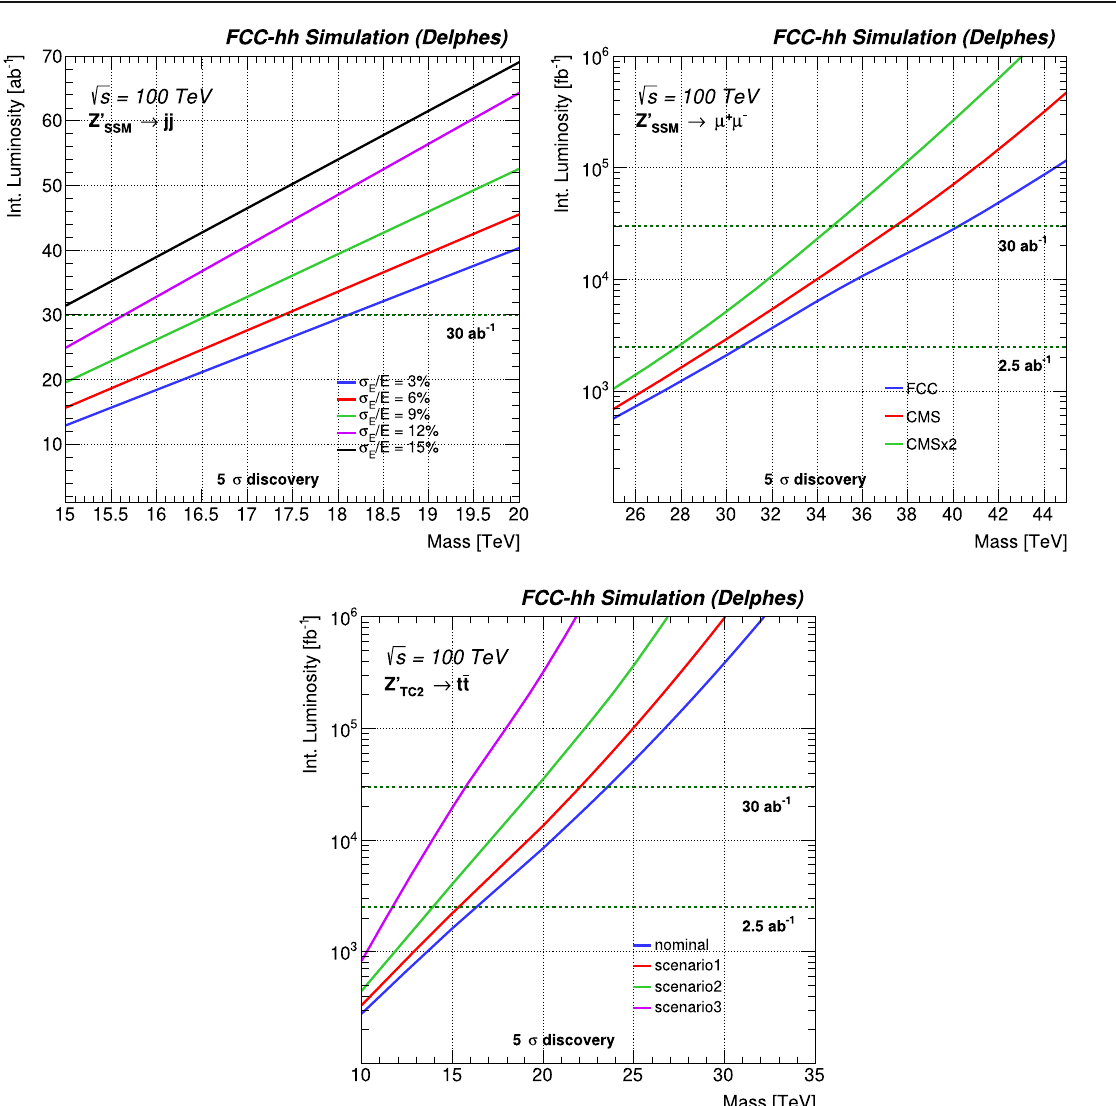
Fig. 13 Luminosity versus mass for a 5 σ discovery for different calorimeter resolution (left), muon resolutions (right) and b-tagging scenarios